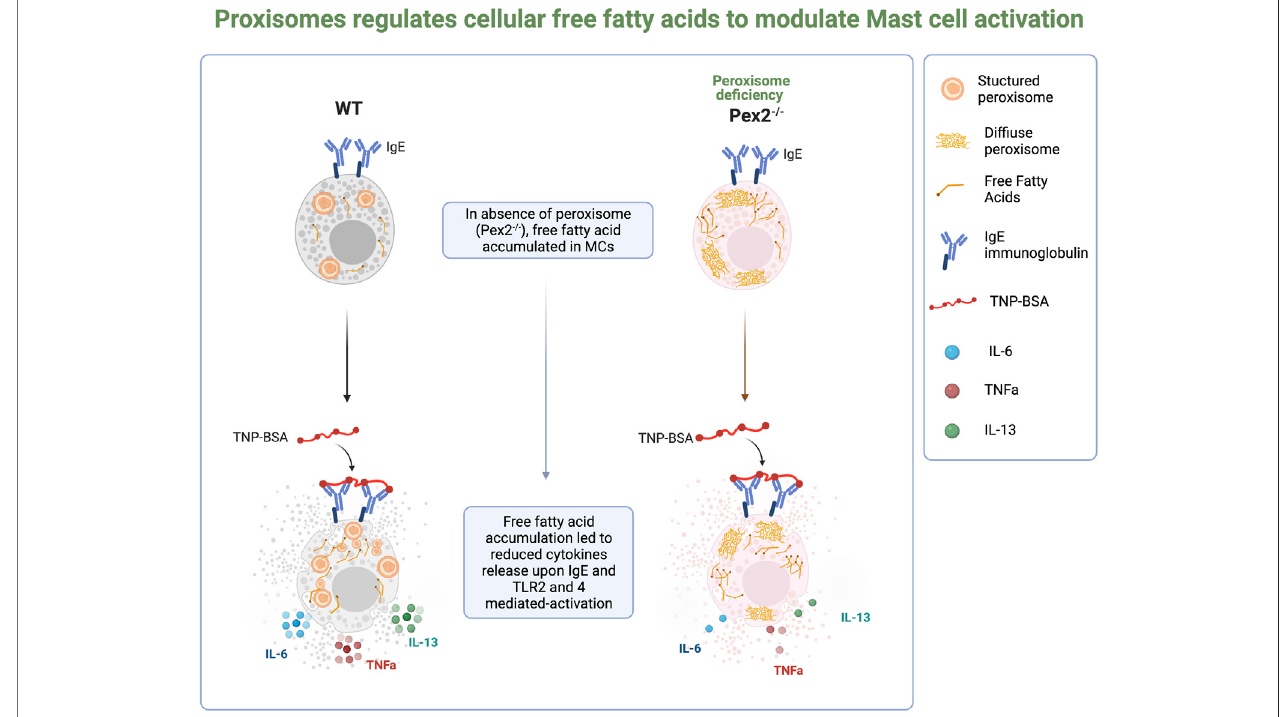
FIGURE 4 | Schematic summary of the fi nding from the